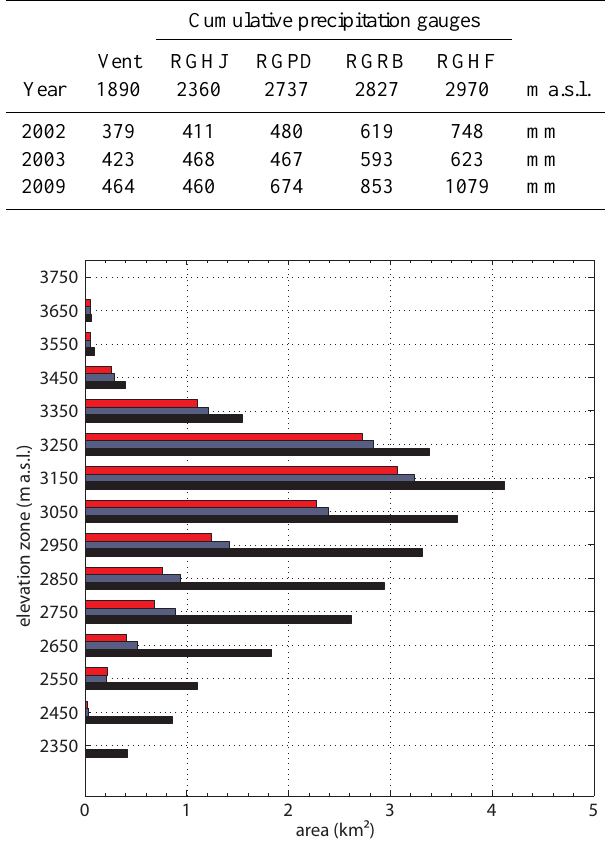
Fig. 2. Area-elevation distribution of the investigated catchment. Catchment area (black), glacier area in 2002 (gray) and glacier area in 2008 (red) are shown in steps of 100m elevation bands.